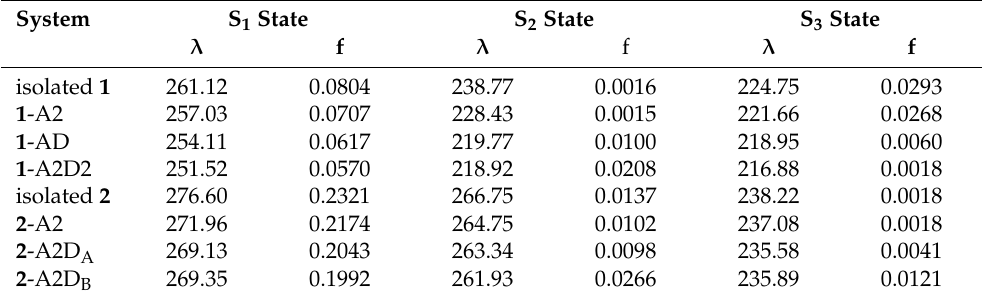
Table 3. Excitation energies (converted to wavelengths λ in nm) and oscillator strengths (f) for three lowest-lying singlet states of the studied N -oxides: isolated molecule vs. microsolvation.